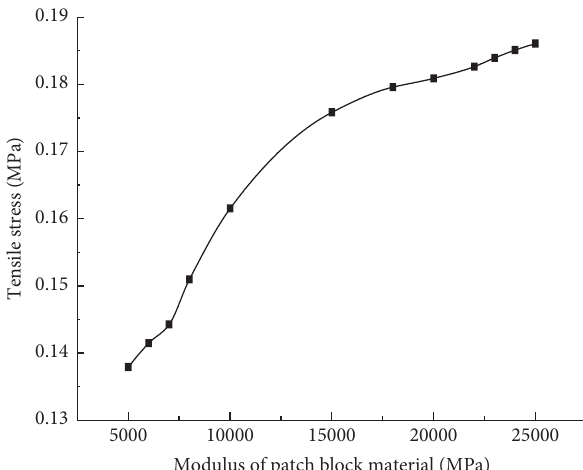
Figure 12: The effect of material modulus on tensile stress of patch block.